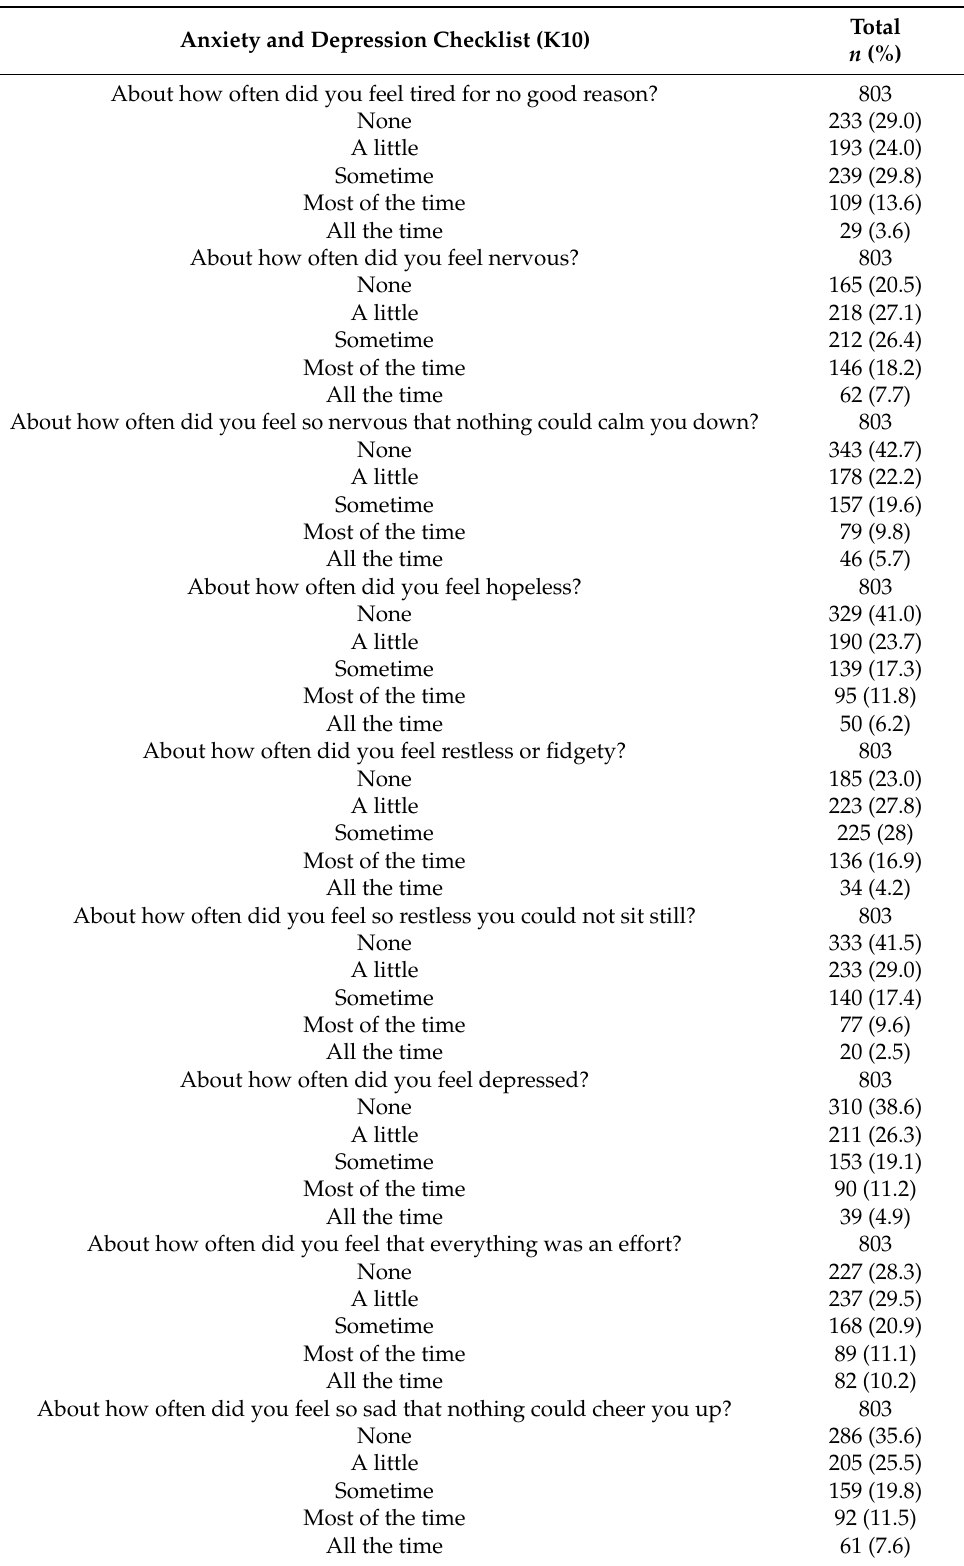
Table 2. Psychological distress among adults during the COVID-19 pandemic in Saudi Arabia. Anxiety and Depression Checklist